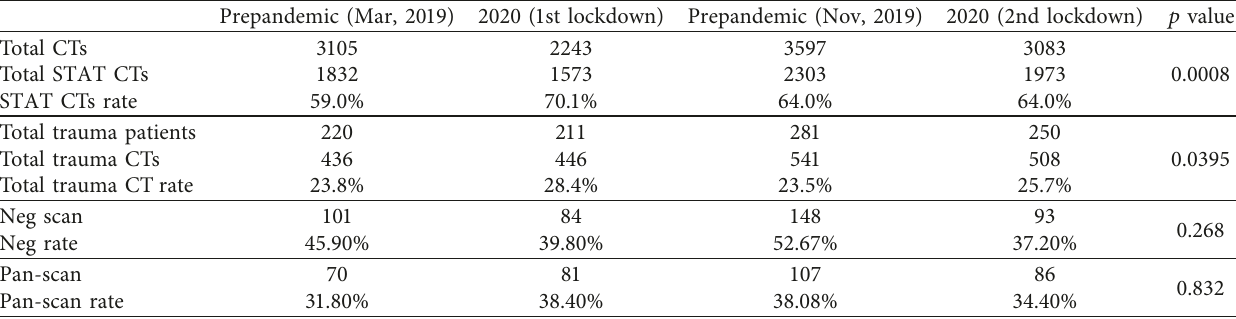
Table 1: The comparison of total CTs, total STAT CTs, total trauma patients, total trauma CTs, the rate of pan-scans, and the percentage of negative CTscans in our level 1 trauma center during two lockdown periods in 2020 versus the corresponding prepandemic period in